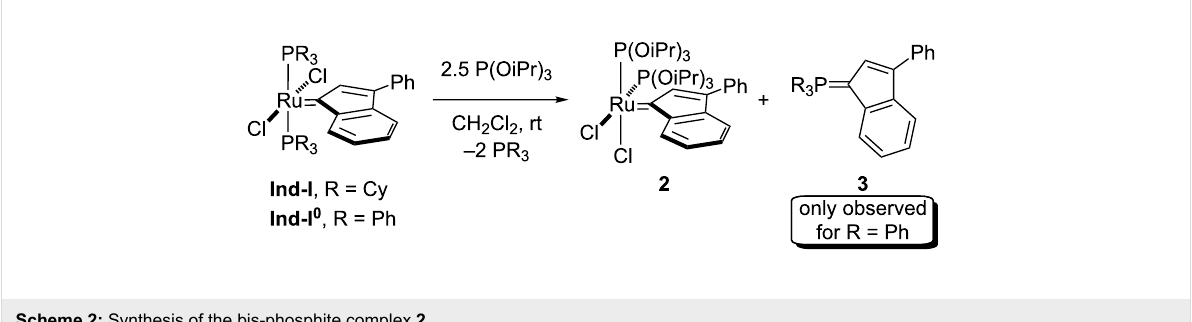
Scheme 2: Synthesis of the bis-phosphite complex 2 .